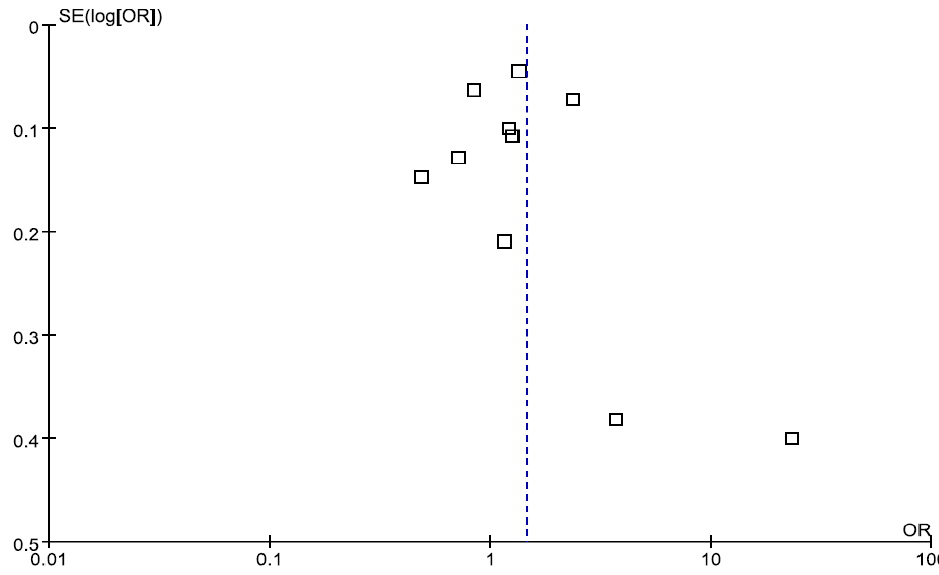
Figure A2. Funnel plots for CHD in the highest compared with the lowest category of intake of the “Western-type” dietary pattern in all studies.